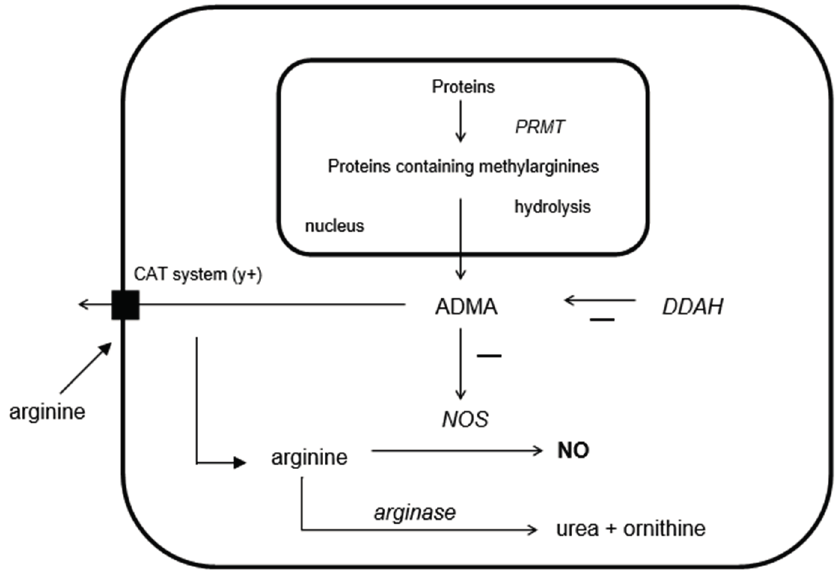
Figure 1. Schematic overview of the interactions between arginine, asymmetric dimethylarginine (ADMA), dimethylarginine dimethylaminohydrolase (DDAH), and nitric oxide synthase (NOS). PRMTs, protein arginine